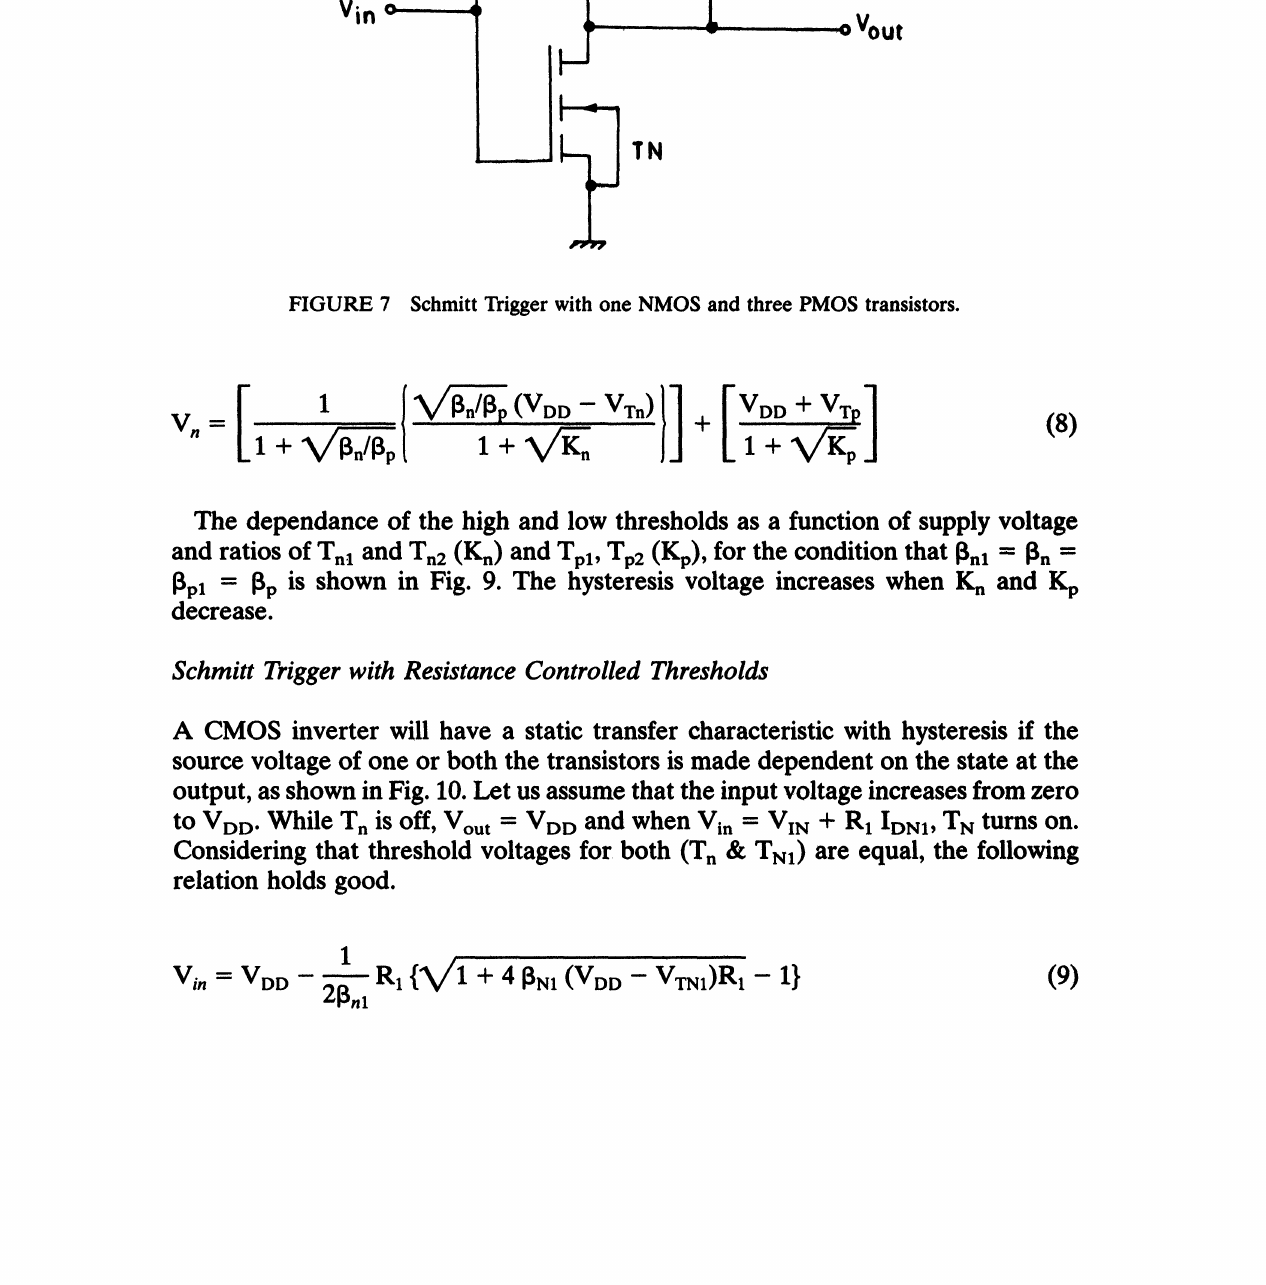
FIGURE 7 Schmitt Trigger with one NMOS and three PMOS